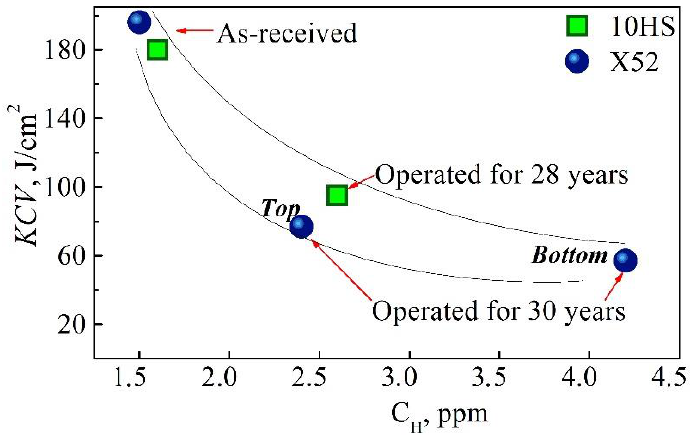
Figure 15. Concentration of hydrogen C H measured by extraction method vs. impact toughness KCV for the 10HS and X52 pipe steels.